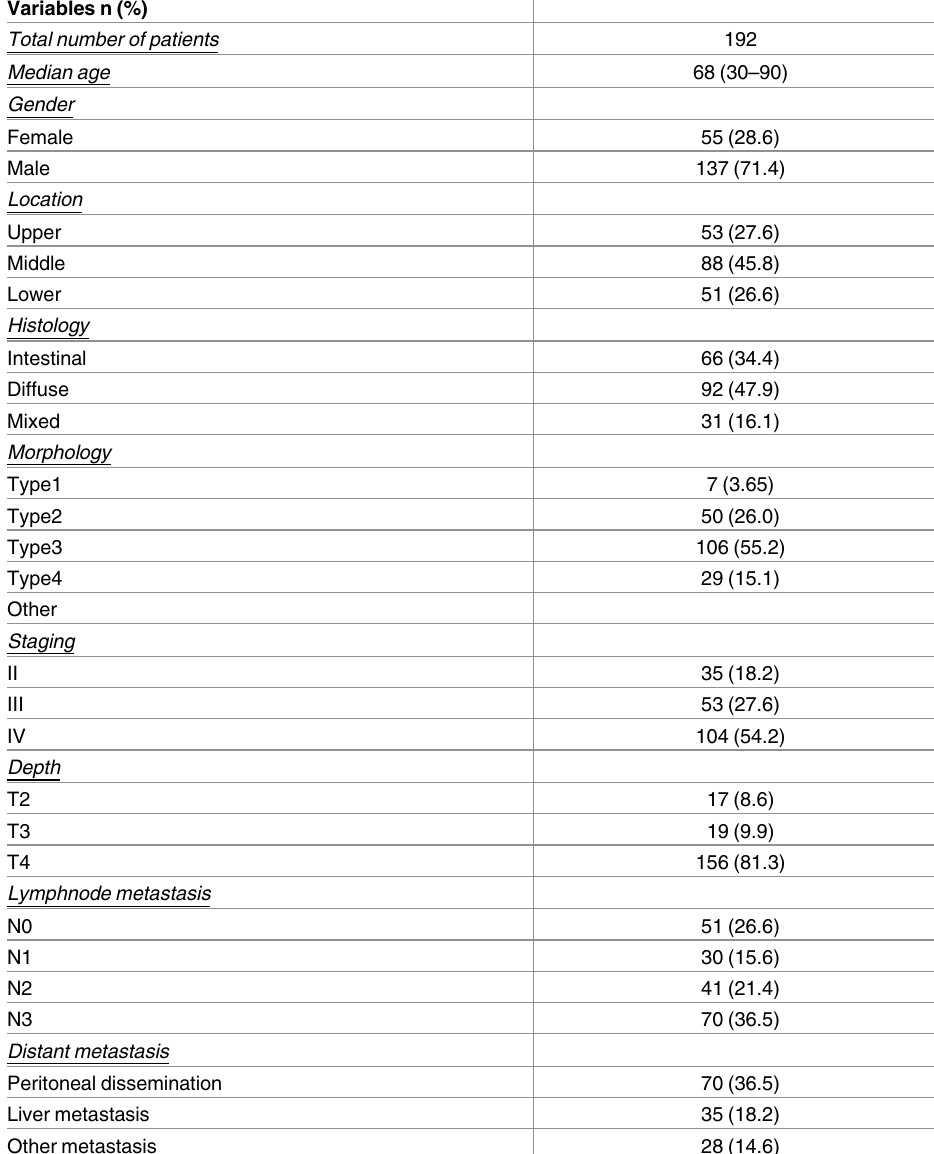
Table 1. Clinic-pathological features of gastric